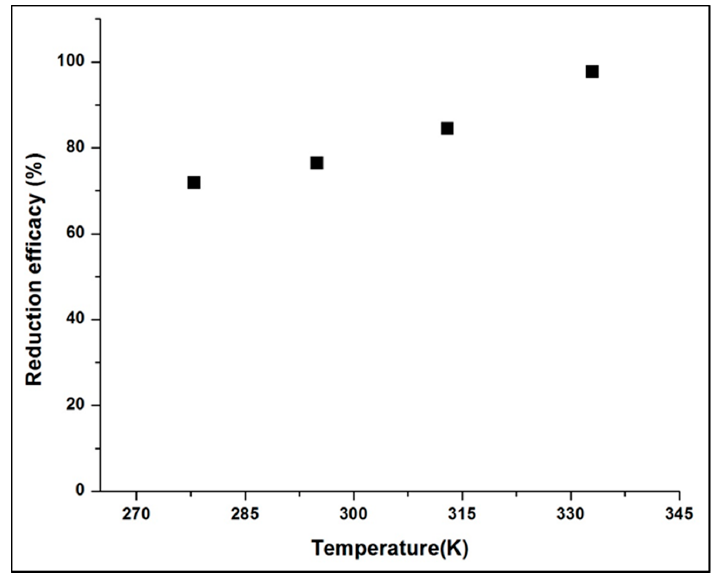
Figure 6. Effects of temperature: [Cr(VI)] 0 = 30 mg·L − 1 , Cr(VI) volume = 25 mL, contact time = 60 min, pH = 2, PLE quantity = 1.5 mL, temperature = 278–333 K.